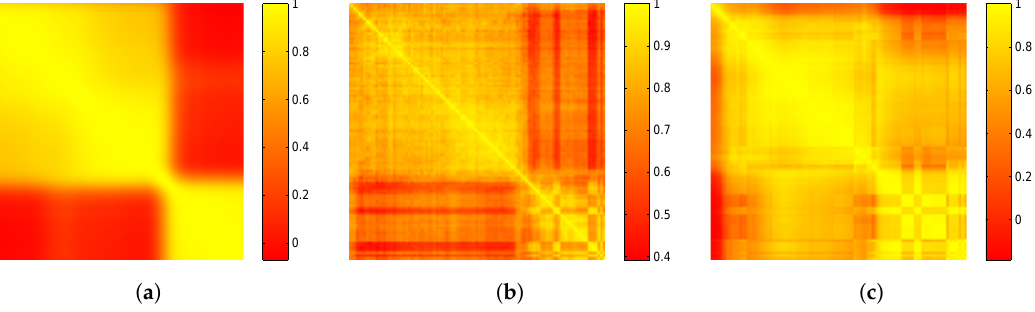
Figure 10. Visualization of the correlation matrix of ( a ) the spectral bands of Pavia hyperspectral image; ( b ) the PS of its spectral bands; ( c ) the distance function of its spectral